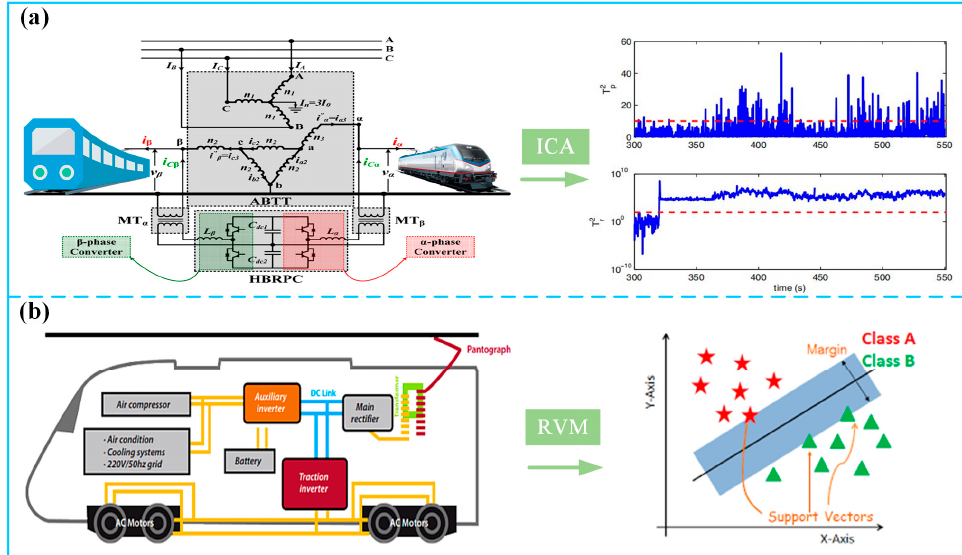
Figure 7. Fault diagnosis method of traction system: ( a ) independent component analysis (ICA) [73]; ( b ) relevant vector machine (RVM).